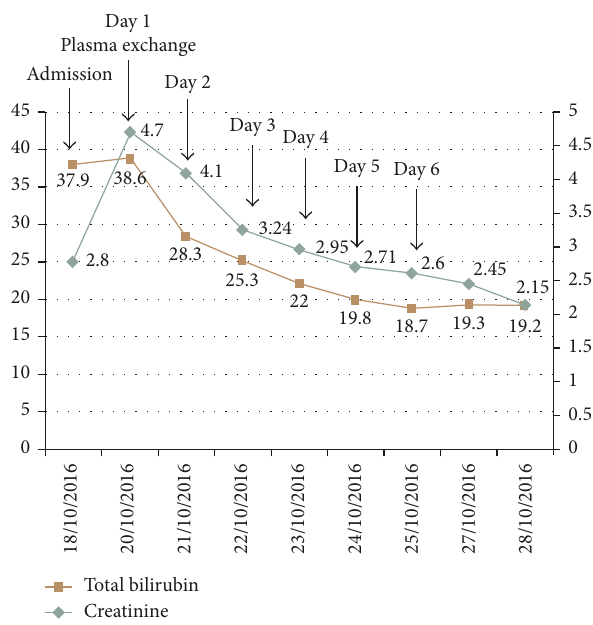
Figure 1: Trend of serum total bilirubin and creatinine levels during hospital